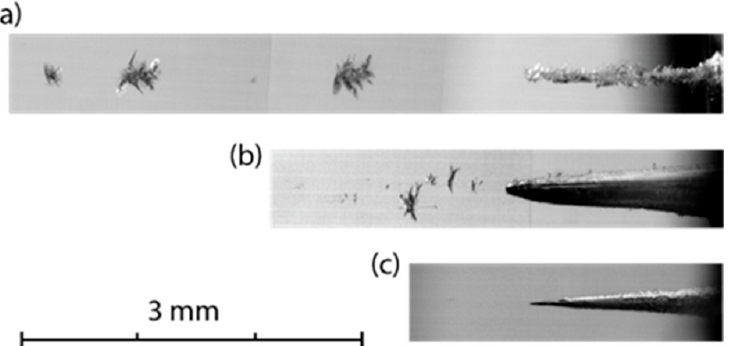
E L ≈ 2 mJ. The laser beam falls on the sample from the right. 2 mJ. The laser beam falls on the sample from the right.